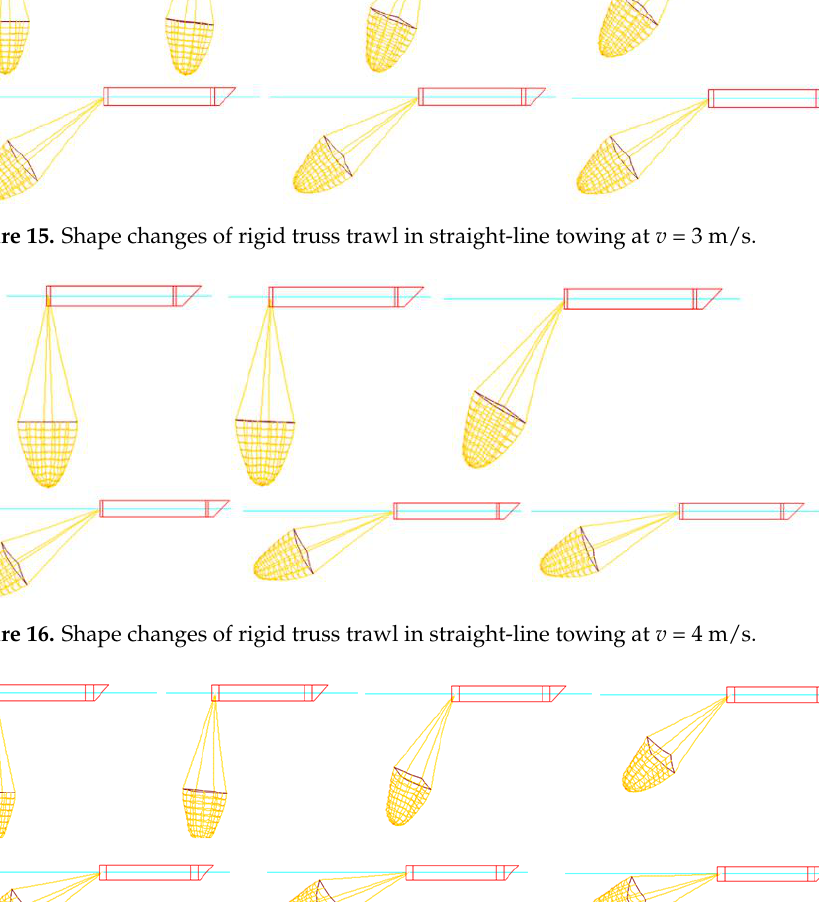
Figure 17. Shape changes of rigid truss trawl in straight-line towing at v = 5 m/s.